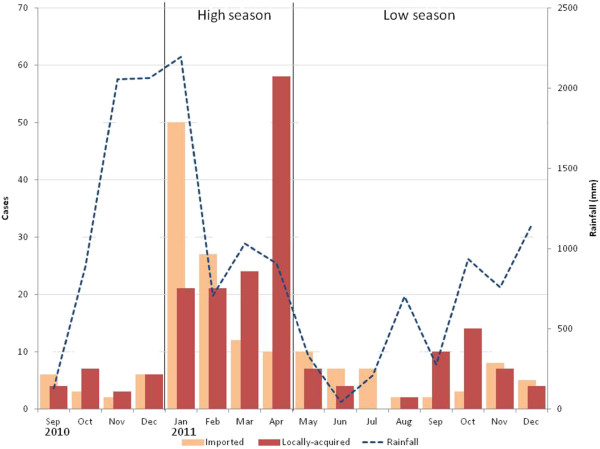
Cases identified by passive and reactive surveillance in Swaziland after implementation of case investigation and concurrent rainfall. The high transmission period of January to April 2011 was mapped separately from the low season of May to December. Cases from 2010 were not used for mapping.